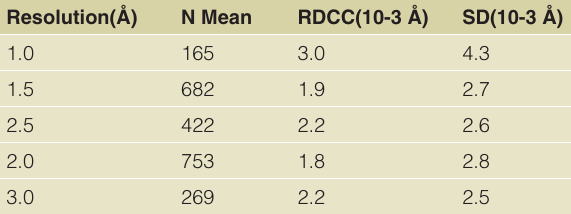
Table 1. Mean and standard deviation (SD) of RDCC values for structures based on resolution. The number N signifies the number of protein structures analzyed that have resolution less than the specified number, but more than the previous one. For example, there are 165 protein with less than 1 Å resolution, and 682 proteins which have more than 1 Å but less than 1.5 Å resolution, and so